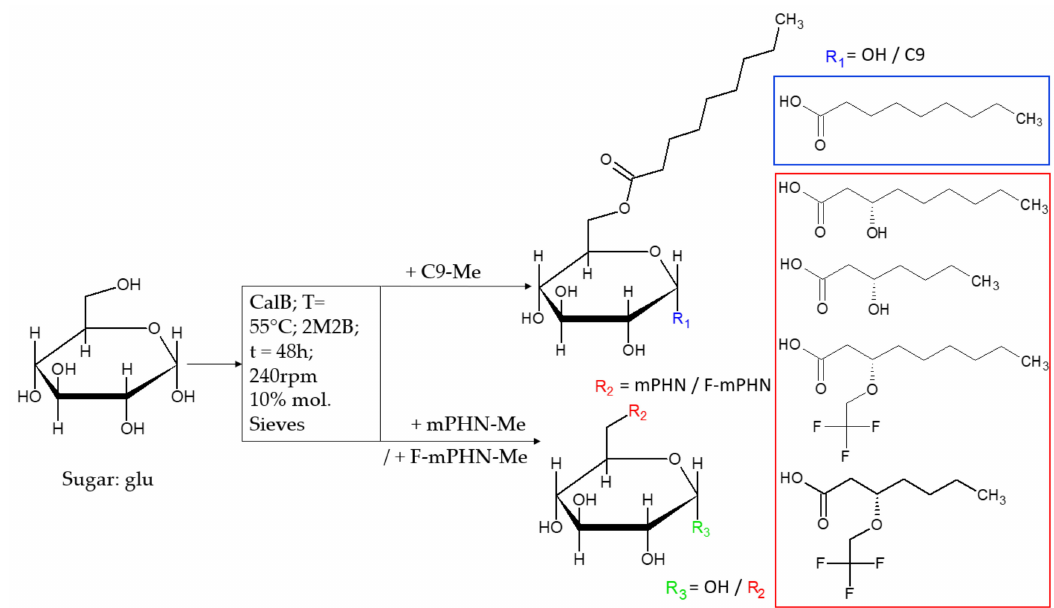
Figure 1. Scheme of sugar fatty acid esters enzymatic synthesis with glucose as an example. The remaining sugar-based SFAEs (galactose and lactose) and all structures of the obtained compounds are presented in Supplementary Figure S1. Where: R 1 : -OH group or nonanoic acid—structure shown in blue rectangle; R 2 : modified or not modified (mPHN or F-mPHN) PHN monomeric residues—their structures are shown in red rectangle; R 3 : -OH group or one of residues which structures are shown in red